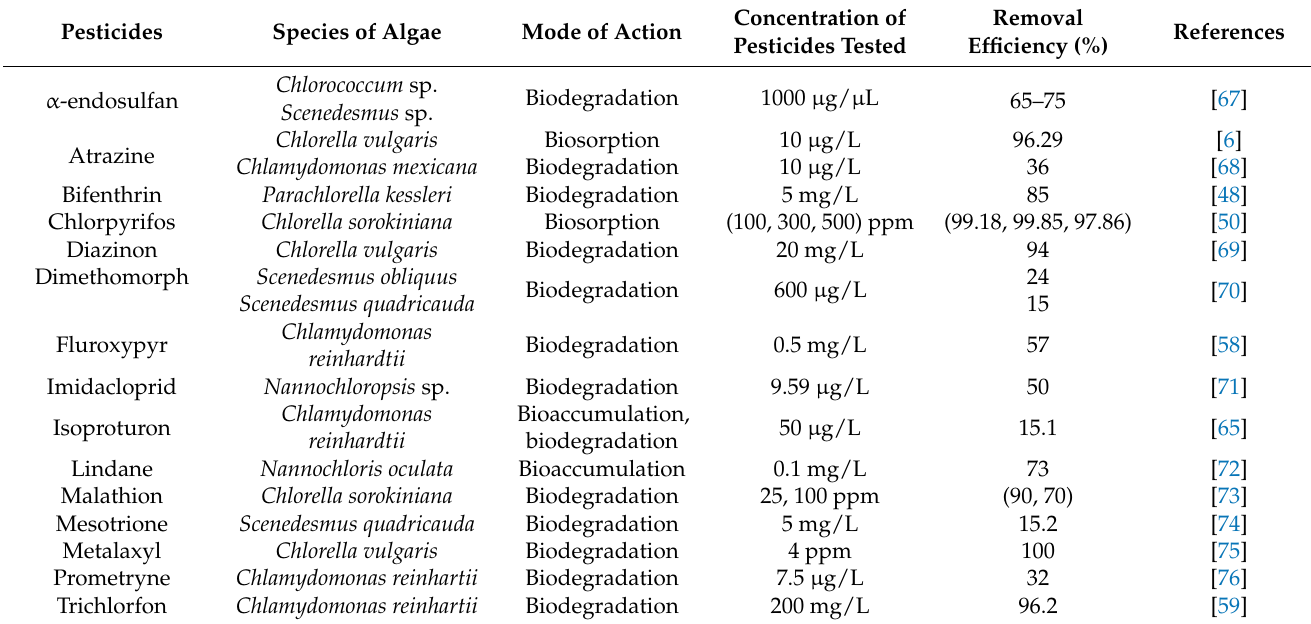
Table 2. Remediation of pesticides by